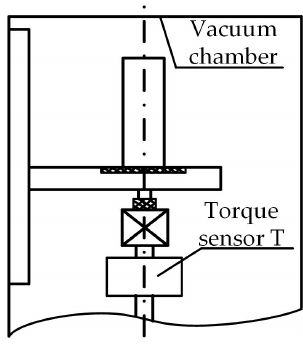
Figure 9. Location of sensor T.